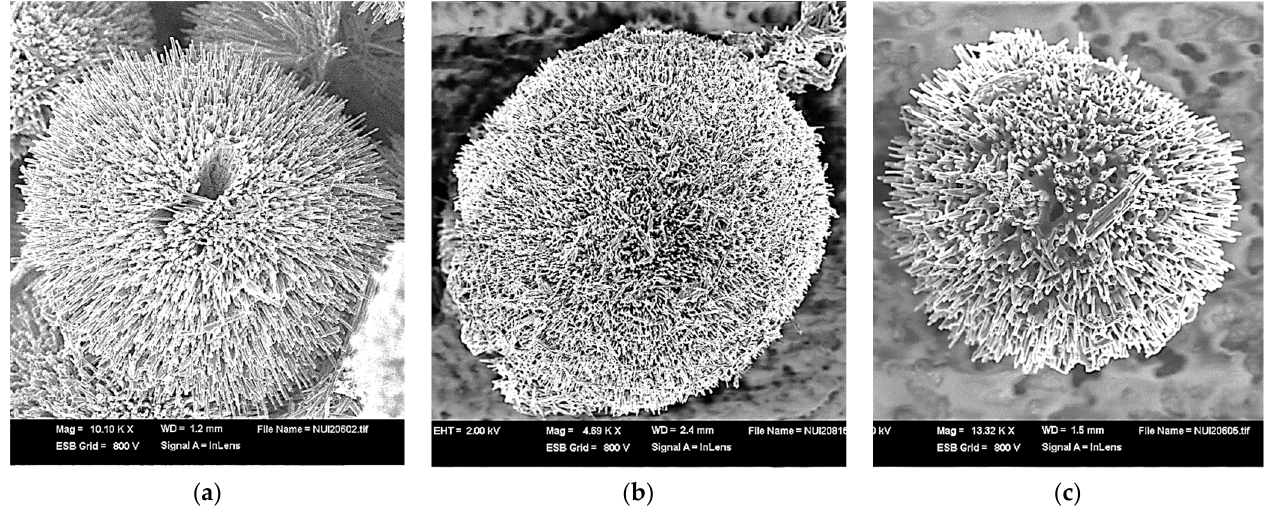
Figure 4. SEM micrographs of vanadium oxide (C 18 H 37 NH 3 ) 2 V 7 O 16 high-density VOx-NTs radial array spherical clusters (nanourchins, VOx-NU): ( a ) hole-centered vanadium oxide nanourchin; ( b ) heavy-sized vanadium oxide nanourchin; (c) isolated vanadium oxide nanourchin.